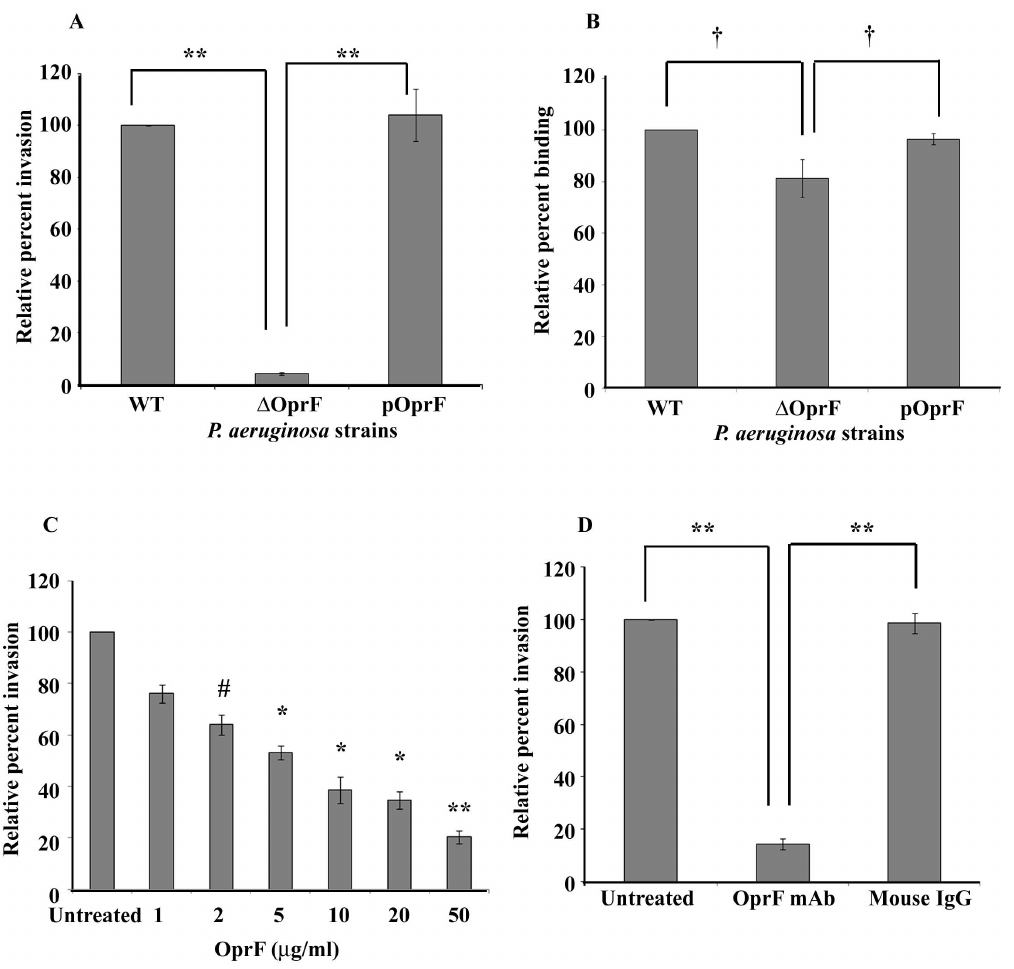
Figure 7. OprF expression in P.aeruginosa is required for HMEECs invasion. HMEECs were infected with P. aeruginosa strains at an MOI of 10 for 2h and bacterial invasion was determined by gentamicin protection assay (A). The binding of P. aeruginosa to HMEECs was also determined (B). In separate experiments HMEECs were pretreated with exogenous OprF (C) or bacteria were pretreated with anti-OprF monoclonal antibody (mAb) (D) and then performed invasion assay. Data represents mean 6 SD. Results were expressed as percentage compared to the invasion or binding of the wild-type strain. # P , 0.05 or * P , 0.01 or ** P , 0.001 or { P . 0.05 compared to WT or pOprF.